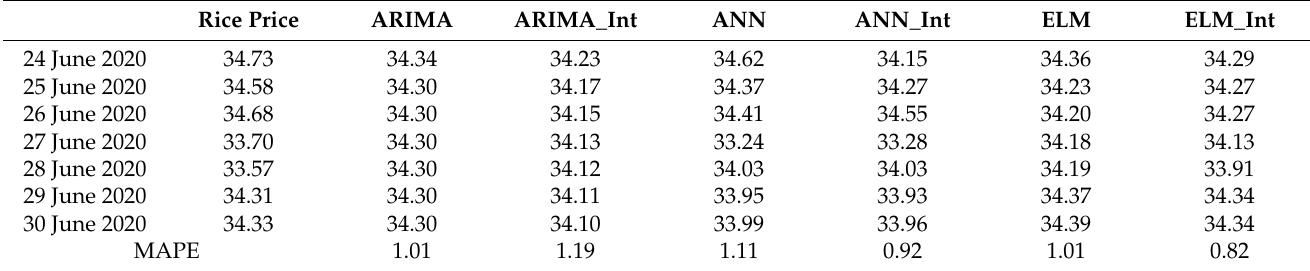
Table 7. Sample forecast using different models in testing